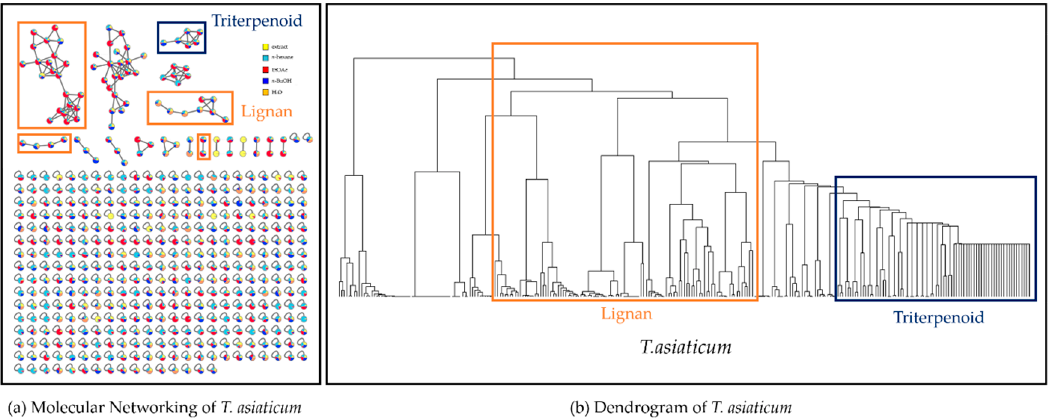
Figure 3. Molecular networking of Trachelospermum asiaticum using the GNPS platform ( a ) and Dendrogram of HCA results ( b ).